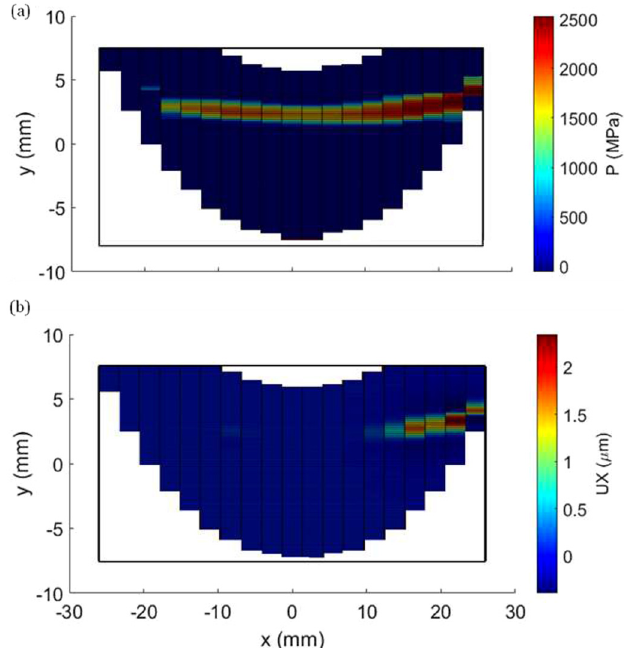
Fig. 7. ISAAC simulations obtained with 750 Nm torque: (a) Nodal force fi eld, (b) Residual bending displacements on the central teeth of the wheel.